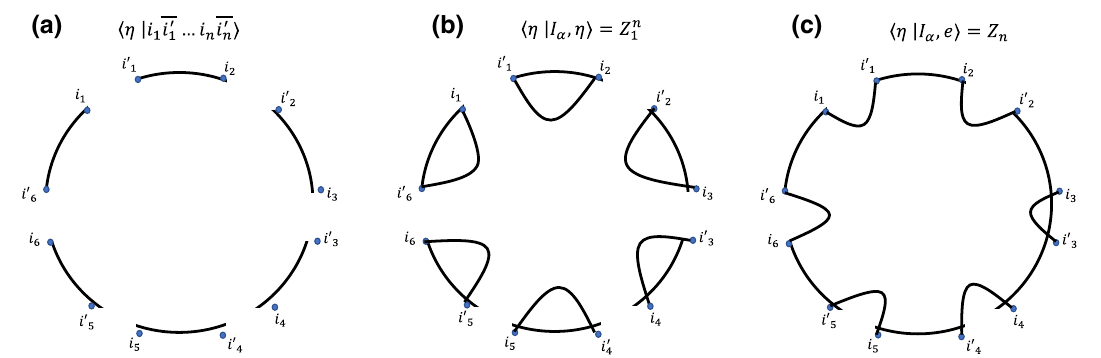
FIG. 7. (a) The “future conditions” corresponding to (cid:4) η | in the expression, Eq. (65), for Tr[ ρ n ]. (b) The diagram corresponding to the dominant contribution from τ = η , while (c) gives an example of a subleading contribution coming from τ = e